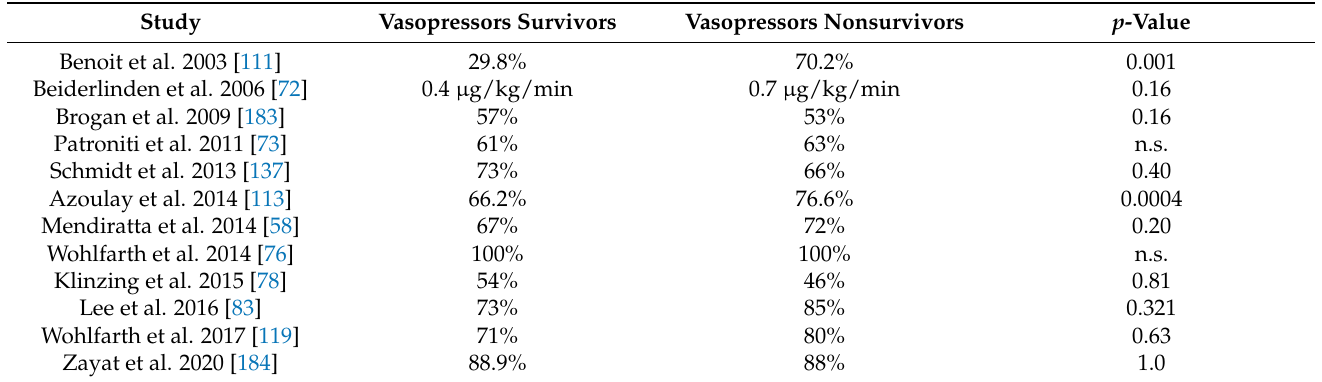
Table 7. Evidence of the lack of difference between survivors and non-survivors with respect to vasopressor use. Values are presented as percentage of patients for whom vasopressors were used in relation to the control group; one study presented absolute mean values. p -Values were extracted from the respective